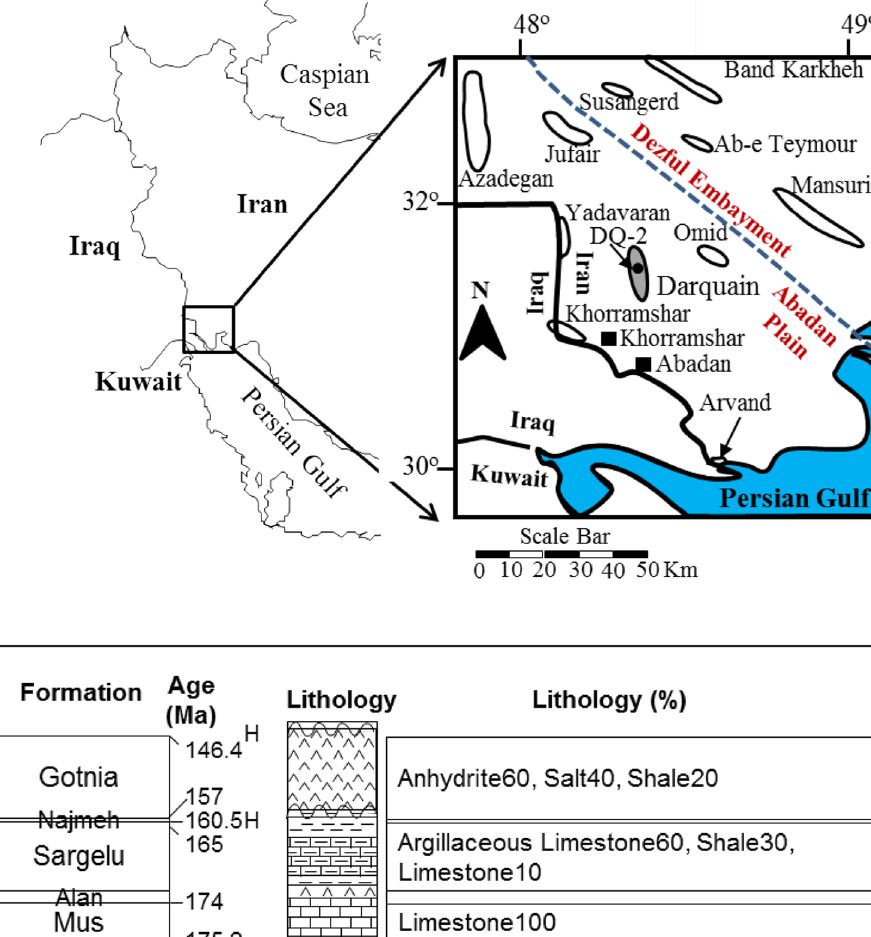
Fig. 1 Location map of the Abadan Plain and Darquain field (based on Abdollahie Fard et al. 2006; Abeed et al. 2012; Bordenave and Hegre 2010)